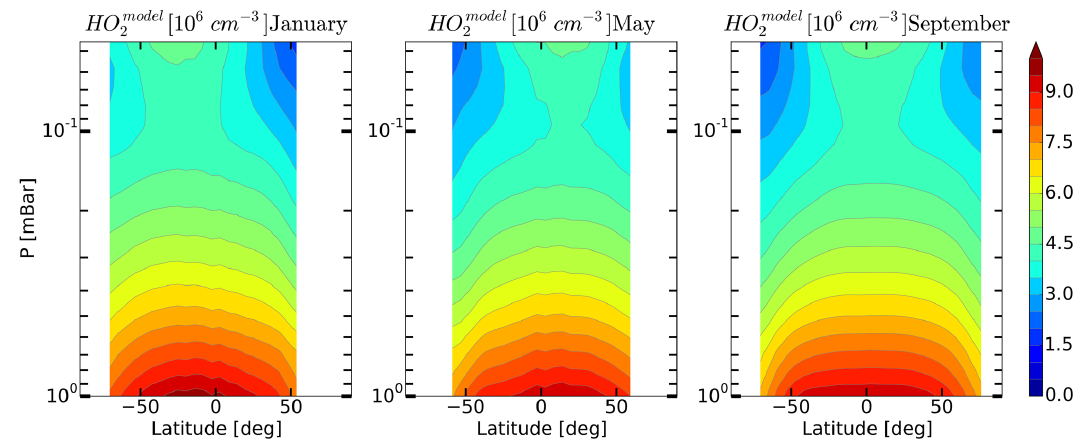
Figure 9. Daytime monthly averaged zonal mean model distributions of HO 2 for January, May, and